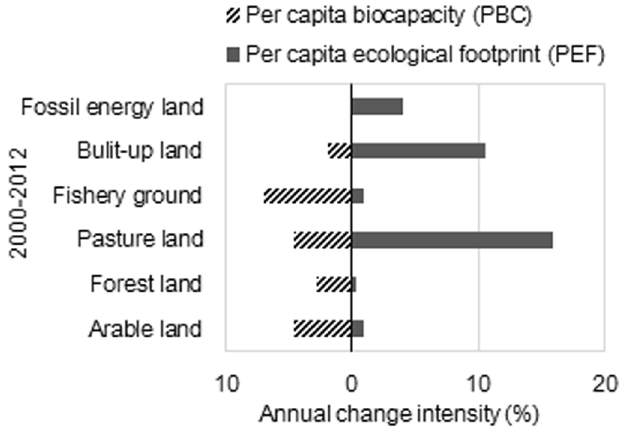
Fig 6. Annual change in intensity of six biologically productive land types between 2000 and 2012 in Xiamen